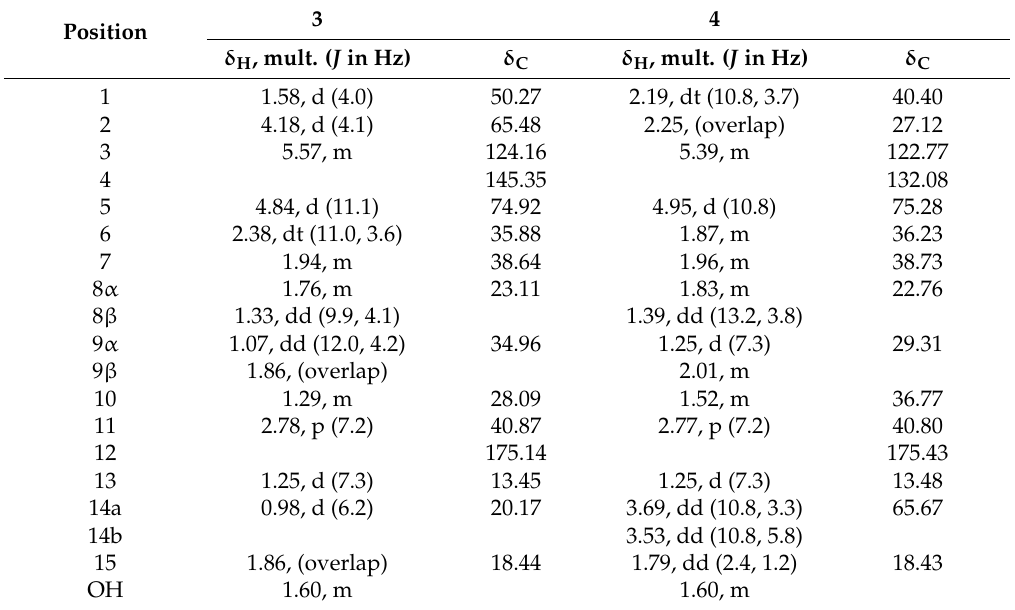
Table 2. 13 C (126 MHz) and 1 H (500 MHz) NMR data for compounds 3 and 4 (in CDCl 3 ).